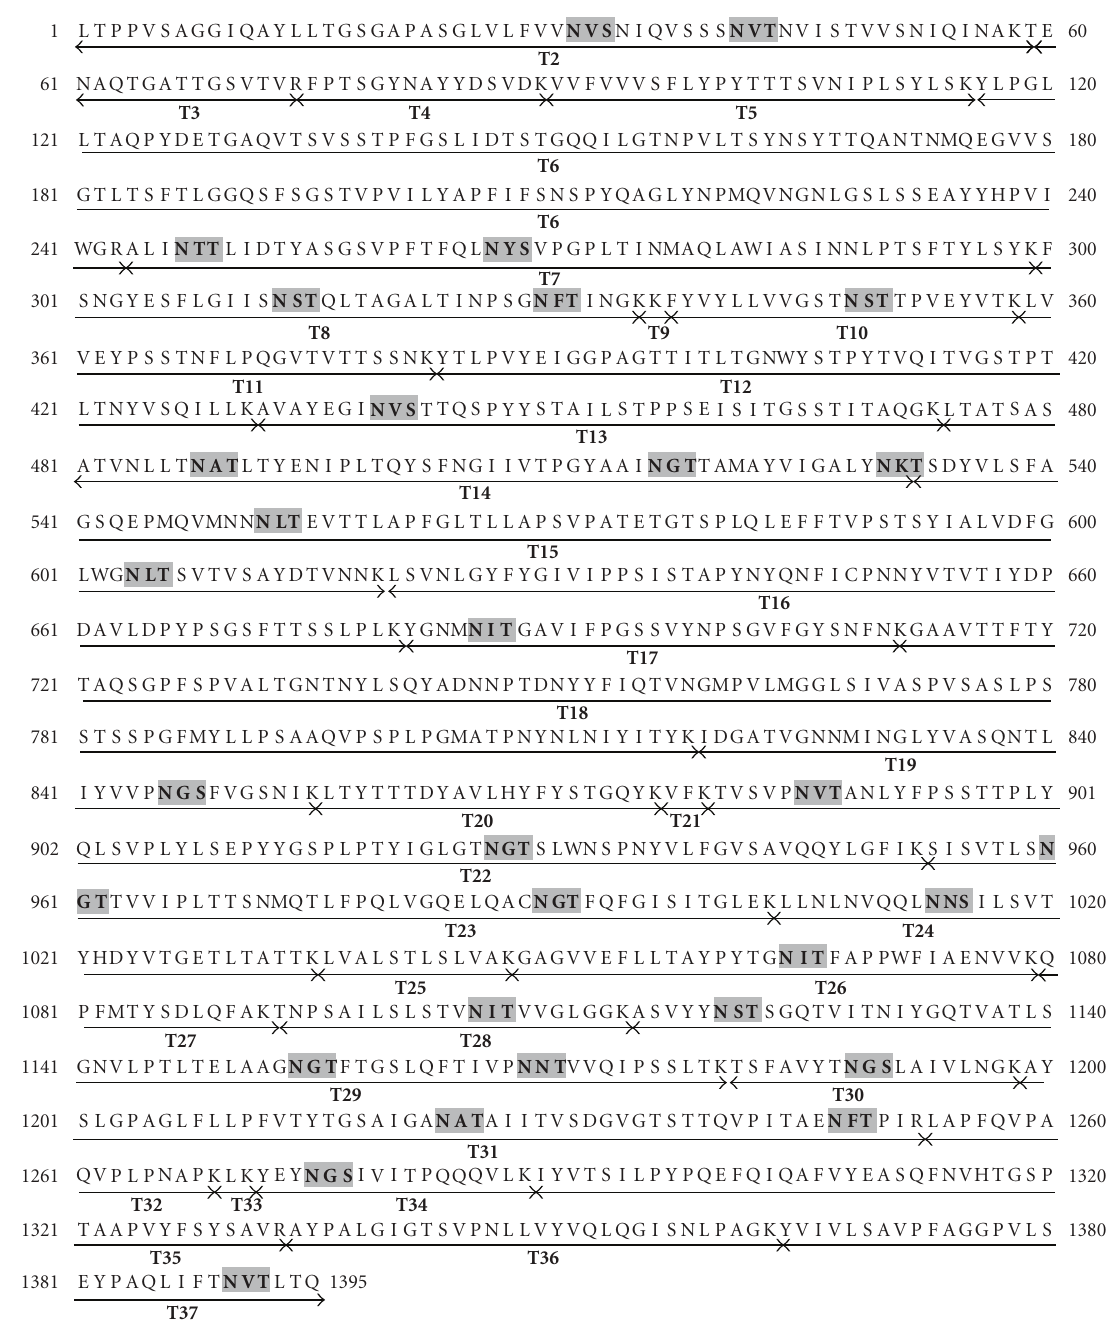
Figure 2: Polypeptide sequence of the S. acidocaldarius S-layer. The N-terminal signal sequence has been omitted. Consensus sequences for N-glycosylation are shaded and the predicted products of tryptic digestion are shown by